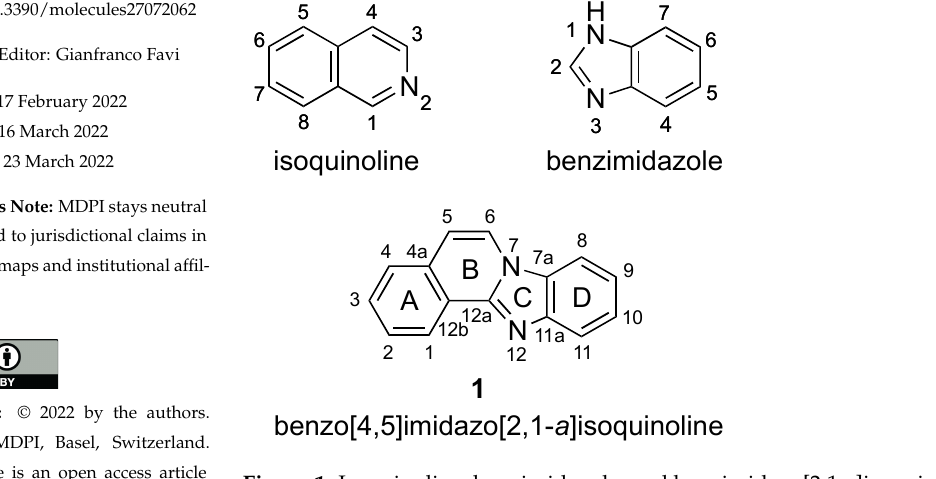
Figure 1. Isoquinoline, benzimidazole, and benzimidazo[2,1- a ]isoquinoline 1 . Synthetic protocols for this class of compounds often include the use of metal reagents/catalysts. Separation of the targeted organic product(s) from these metal-containing catalysts or reagents is required to minimize sources of auxiliary toxicity and meet the